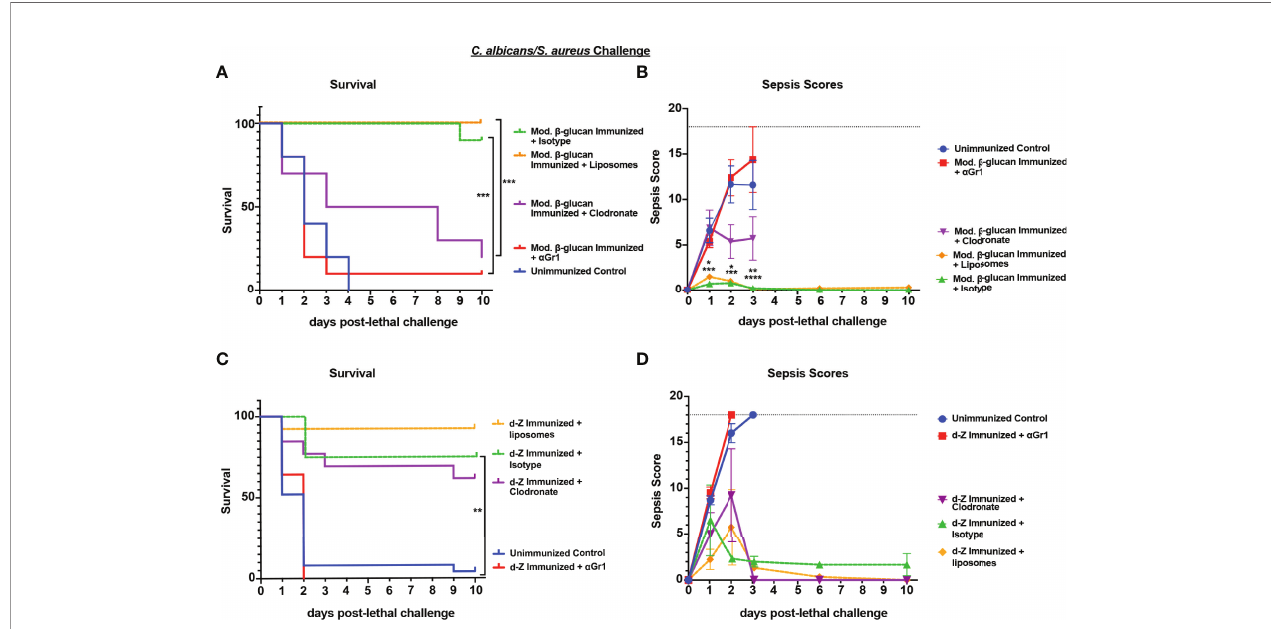
FIGURE 6 | Role of macrophages and Gr-1+ leukocytes in b -glucan-induced protection against lethal polymicrobial C. albicans/S. aureus IAI. Mice (n= 10/group) were immunized with either modi fi ed b -glucan (A, B) or d-zymosan (C, D) prior to lethal challenge as described in Figure 5 . For macrophage depletion, mice were injected i.p. with liposome-encapsulated clodronate or control empty liposomes 1 day prior to lethal challenge. For Gr-1+ cell depletion, mice were injected i.p. with 200 m g anti-Gr-1 or isotype control antibody 48 h prior to and 2 h after lethal challenge. Mice were challenged with 700-1000 mg/kg zymosan and monitored for (A, C) survival and (B, D) morbidity/sepsis scoring following lethal challenge for 10 days. Naïve (unvaccinated) mice served as the negative control. Graphs are representative of at least 3 separate experiments. The exception is (A) that shows cumulative data of 3 separate experiments. *, P<0.05; **, P<0.01; ***, P<0.001; ****, P<0.0001 [for values signi fi cantly different from those of the control, by log rank Mantel-Cox test (survival) and ANOVA followed by post hoc Student ’ s t-test (sepsis